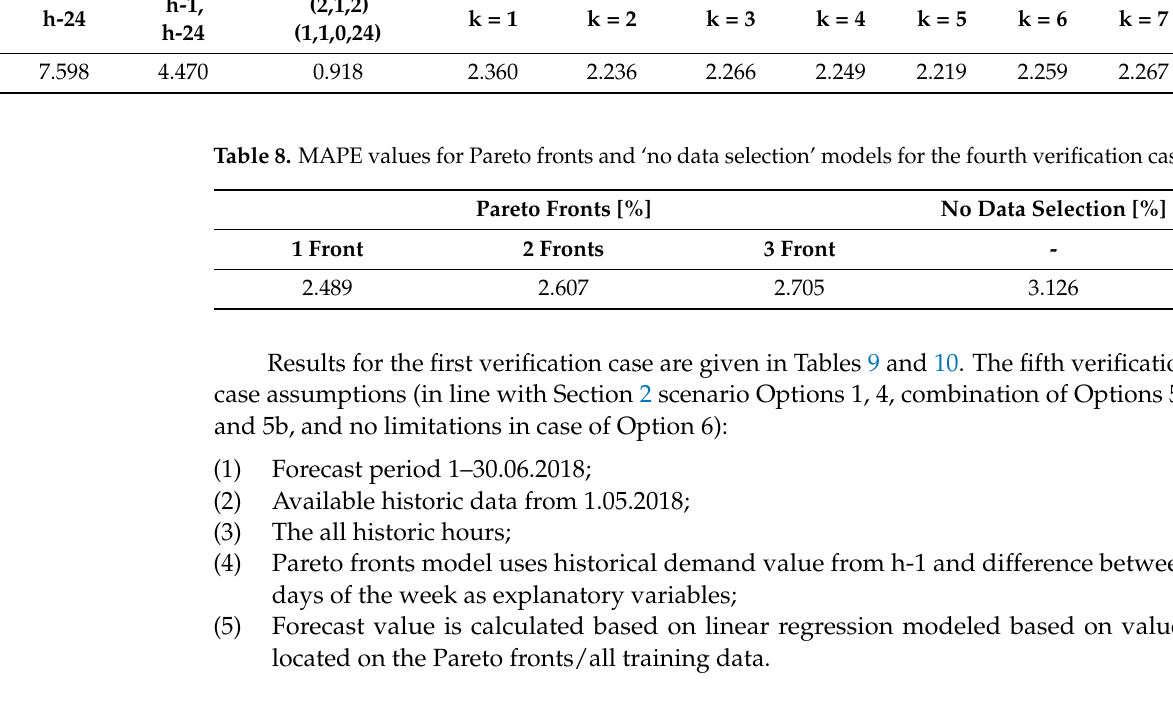
Table 7. MAPE values for naïve approach, SARIMAX model, and kNN algorithm for the fourth verification case. Naïve Approach [%] SARIMAX [%]